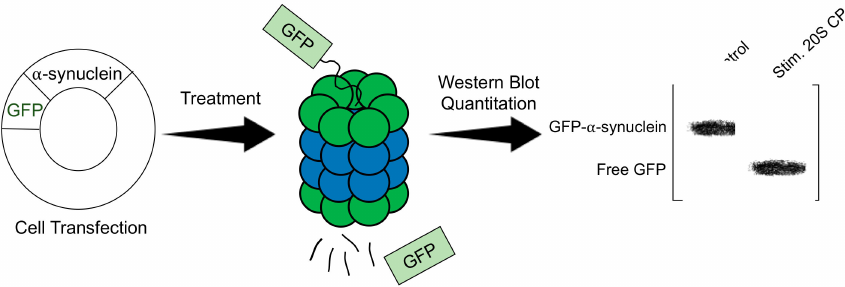
Figure 4. General procedure of evaluating a 20S CP stimulator in cells using a GFP- α -synuclein fusion